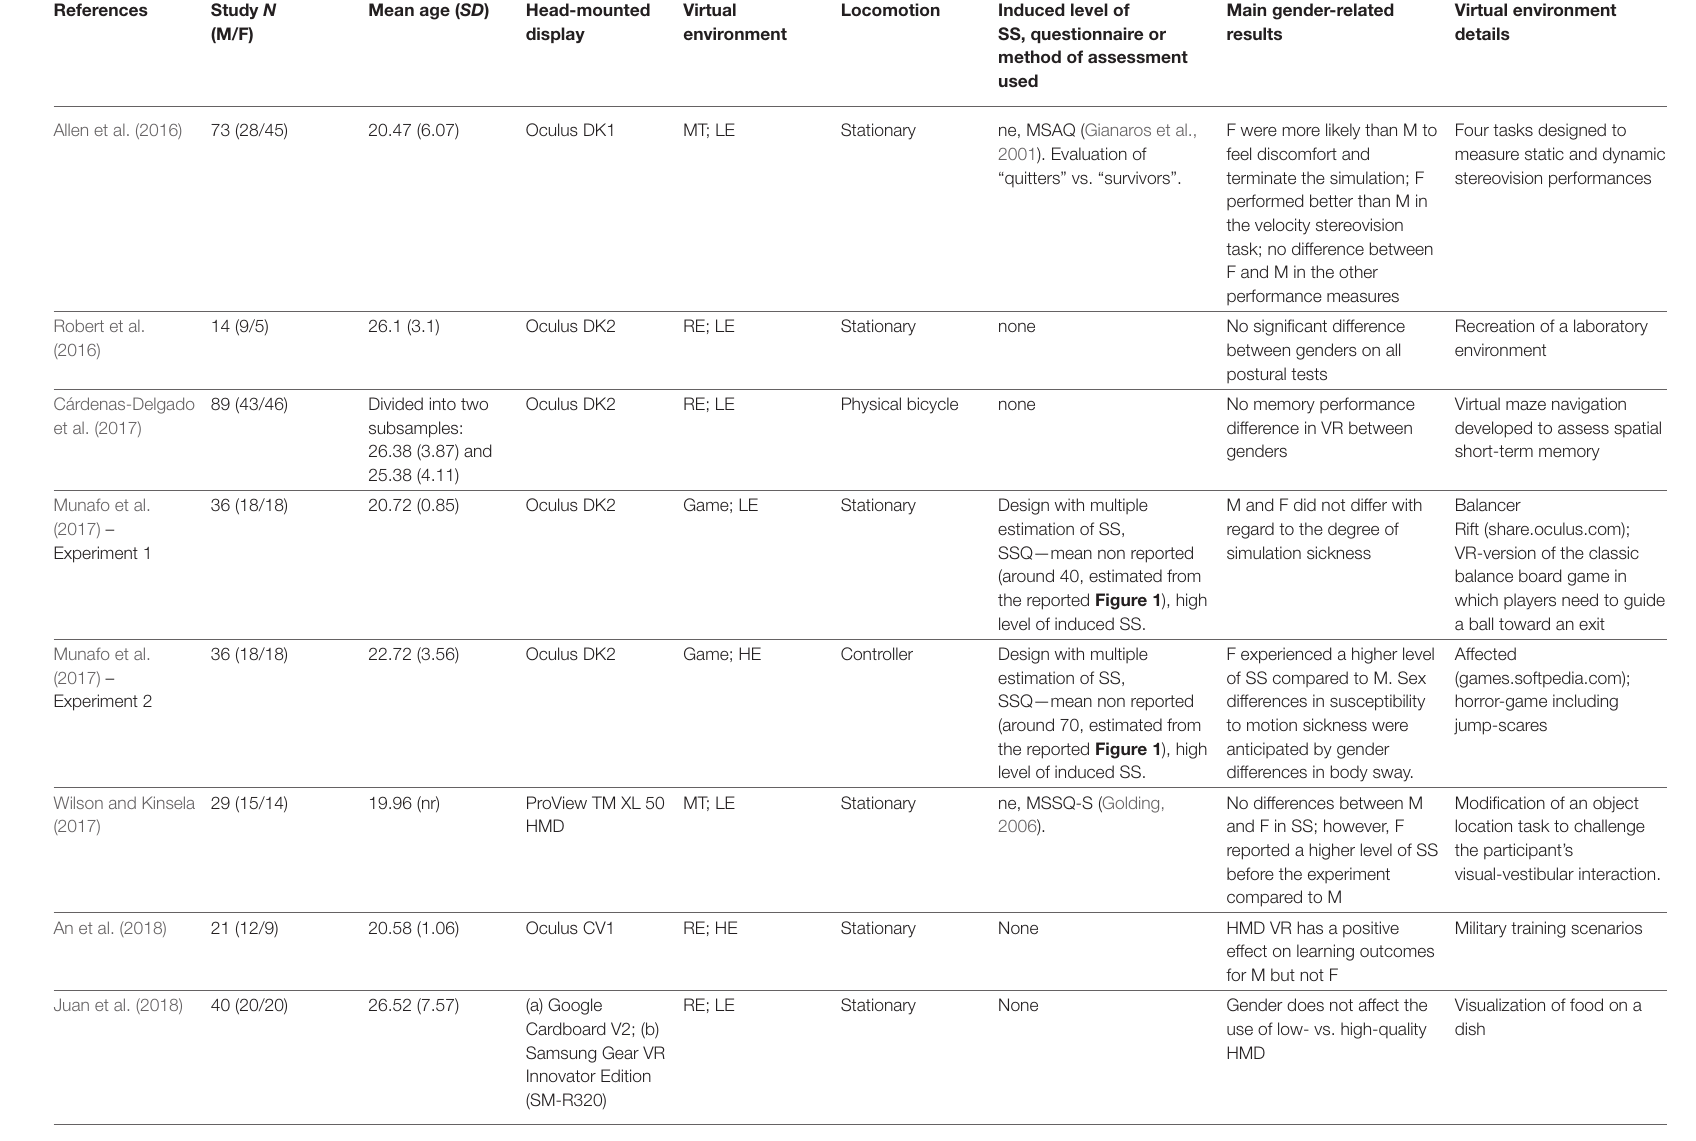
TABLE 1 | List of studies included from the literature